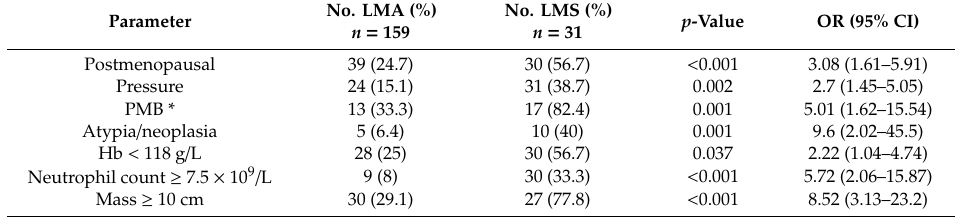
Table 1. Comparison of preoperative parameters between leiomyoma and LMS groups. Parameter